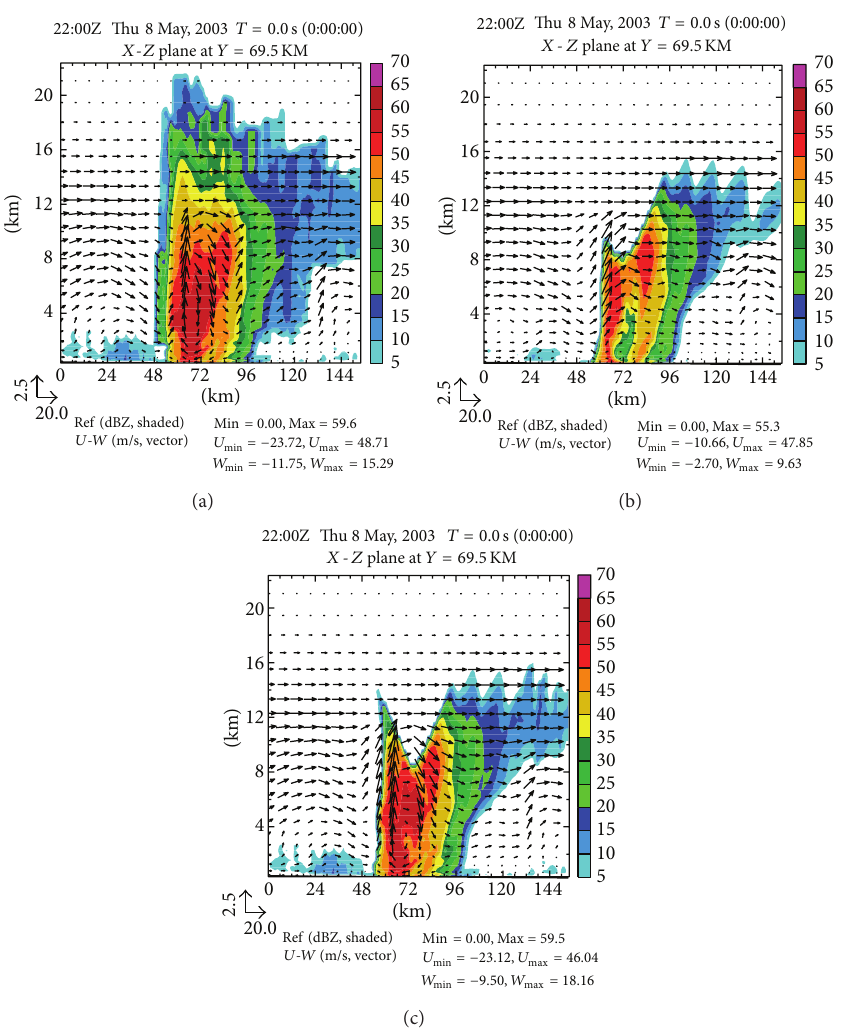
Figure 10: East–west cross section of reflectivity and wind vectors through the center of the storm at 2200 UTC for the (a) control analysis, (b) the 1RAD analysis, and (c) the 2RAD